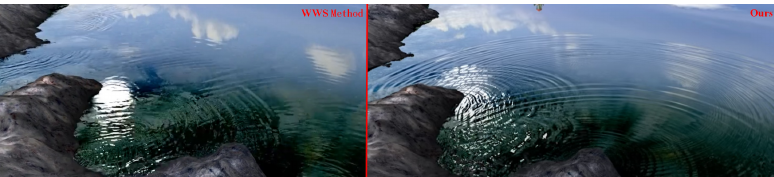
Figure 10. Effect of collisions between water and the solid boundary using the WWS [8] (L) method and our method (R).